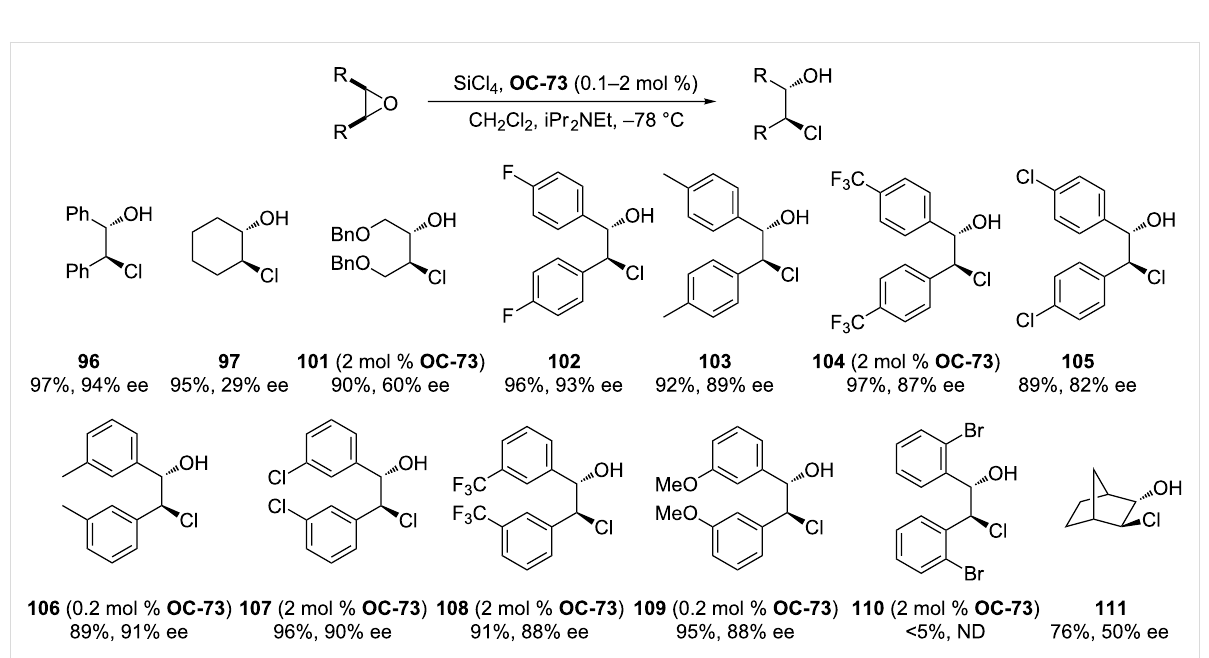
Figure 15: The Chiral phosphine oxides ( OC-70 to OC-77 ) based on an allene backbone.